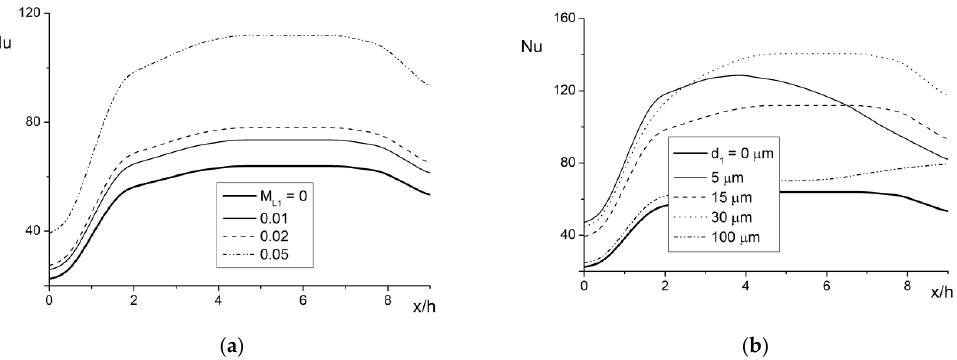
Figure 10. The effect on the heat transfer rate of the droplet mass fraction at the inlet ( a ) and their diameter ( b ). Re = 1.6 × 10 4 . ( a ) d 1 = 15 μm; ( b ) M L 1 = 0.05.